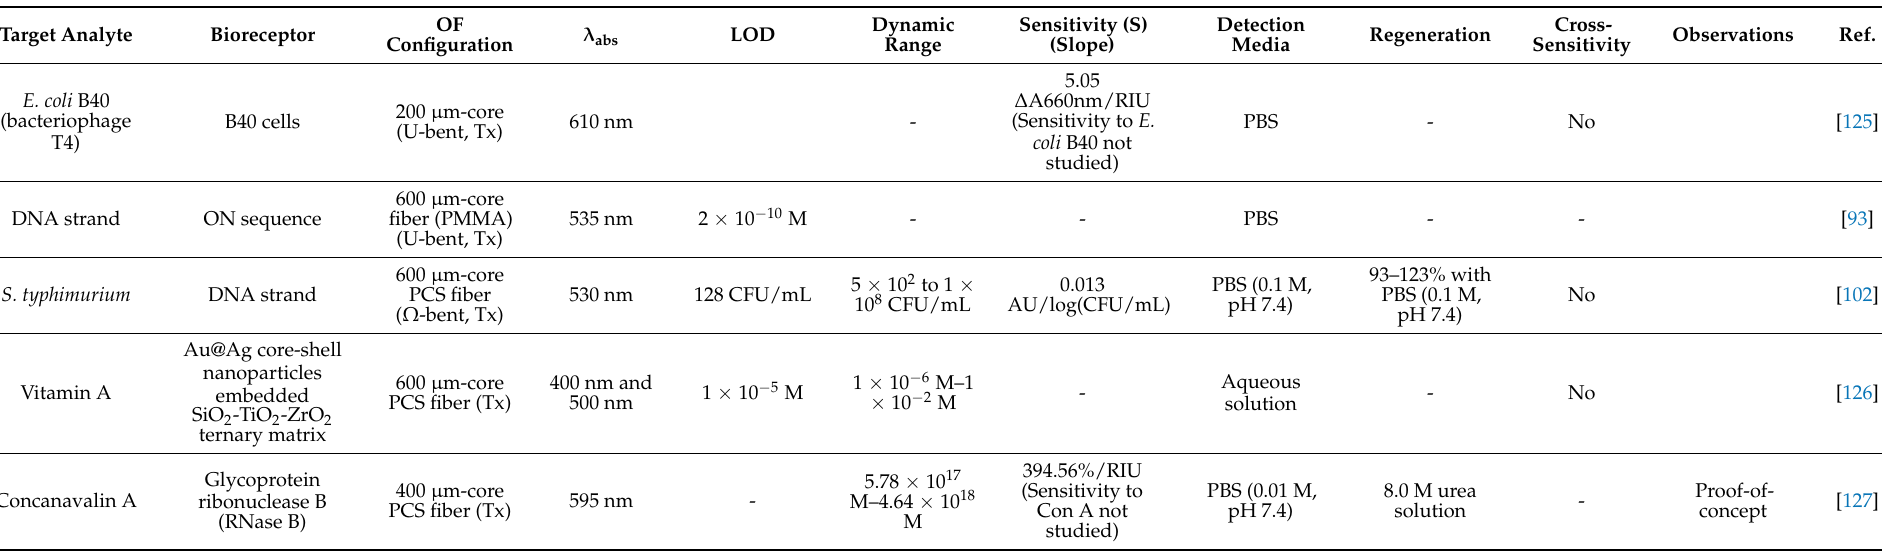
Table 8. Optical fiber biosensors based on absorption using bioreceptors different from antibodies and enzymes. The dash indicates that information about that parameter is not available in the original